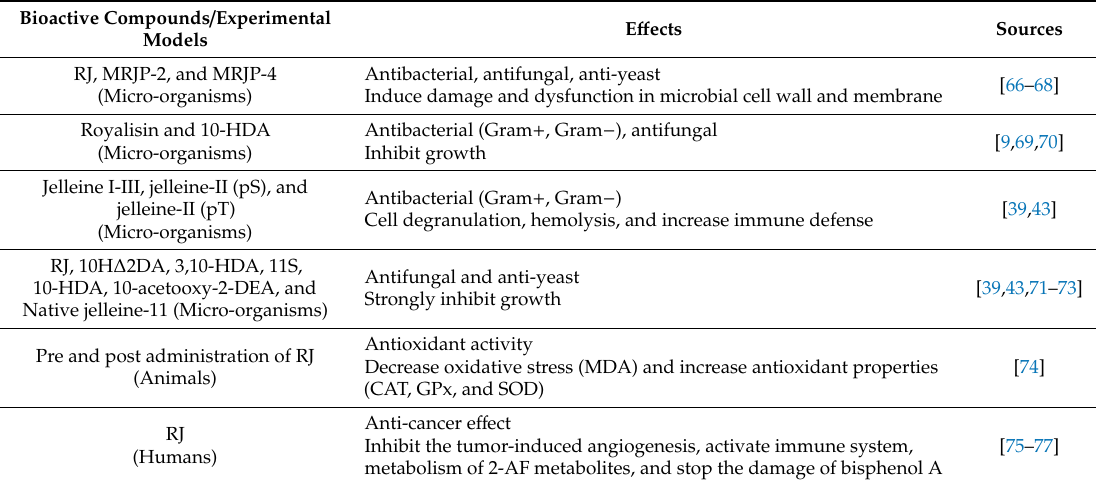
Table 1. The biological activities and pharmaceutical applications of RJ and their bioactive ingredients. Bioactive Compounds / Experimental